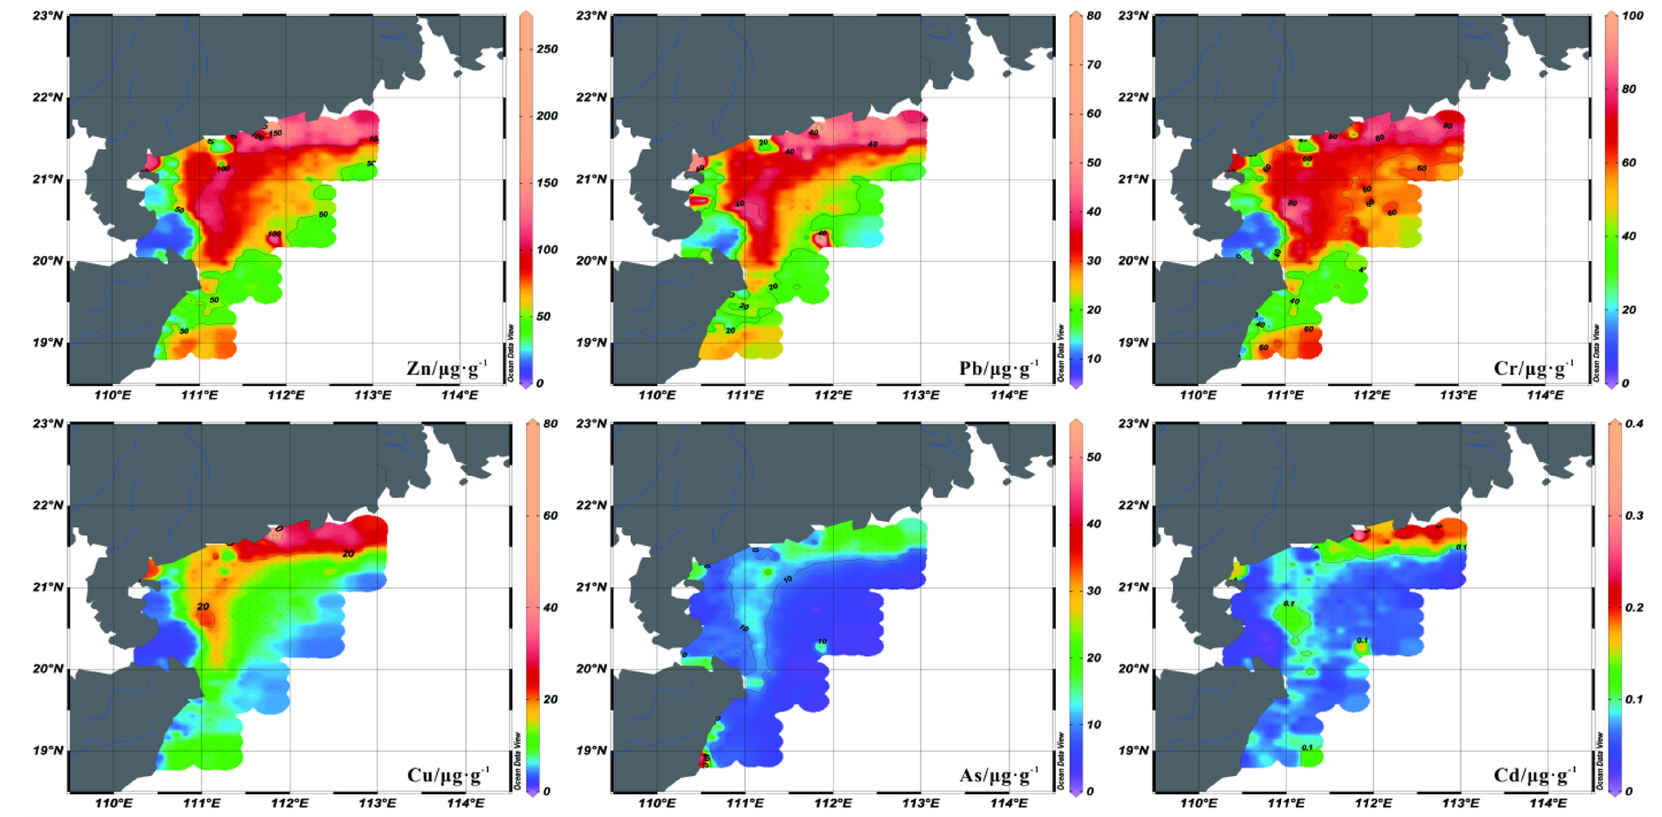
Figure 2. Spatial distribution patterns of the contents for heavy metals in the study